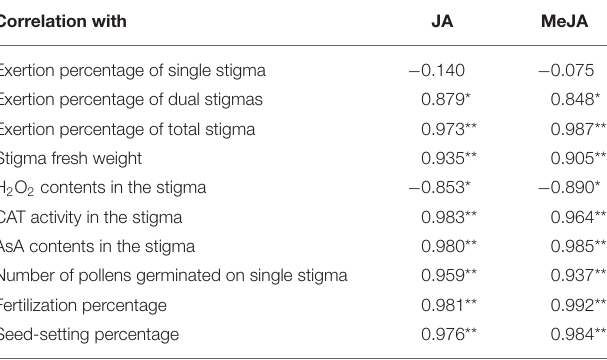
TABLE 3 | Correlations of the jasmonic acid (JA) and methyl jasmonate (MeJA) contents with stigma vitality traits of rice. Correlation with